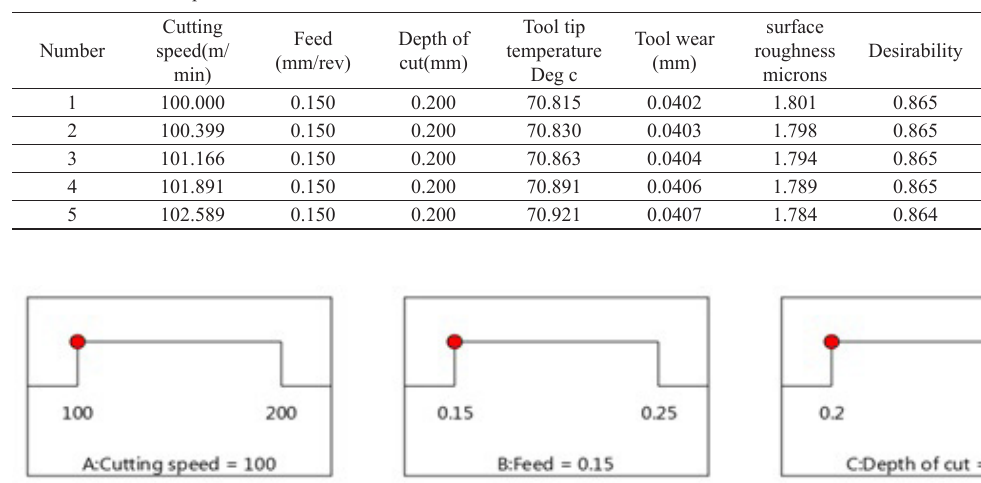
Table 9. Multi set of optimal solutions.